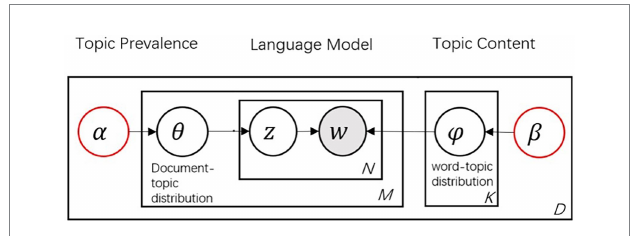
FIGURE 1 Plate diagram of latent Dirichlet allocation.